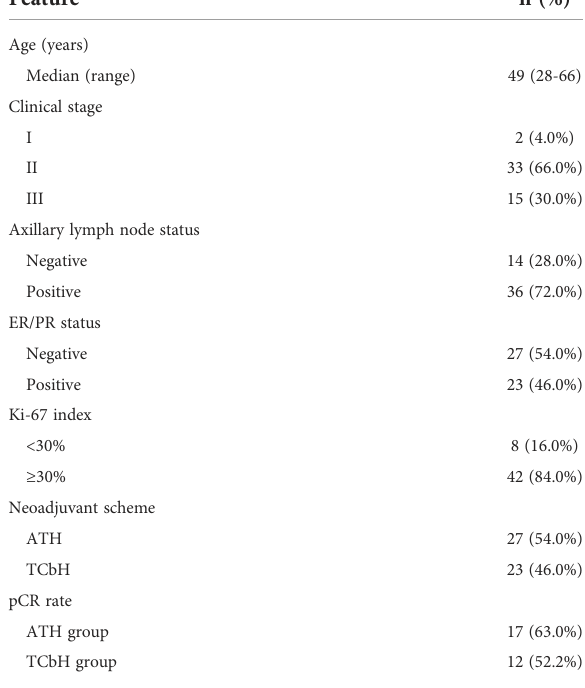
TABLE 1 Baseline characteristics of patients (n =